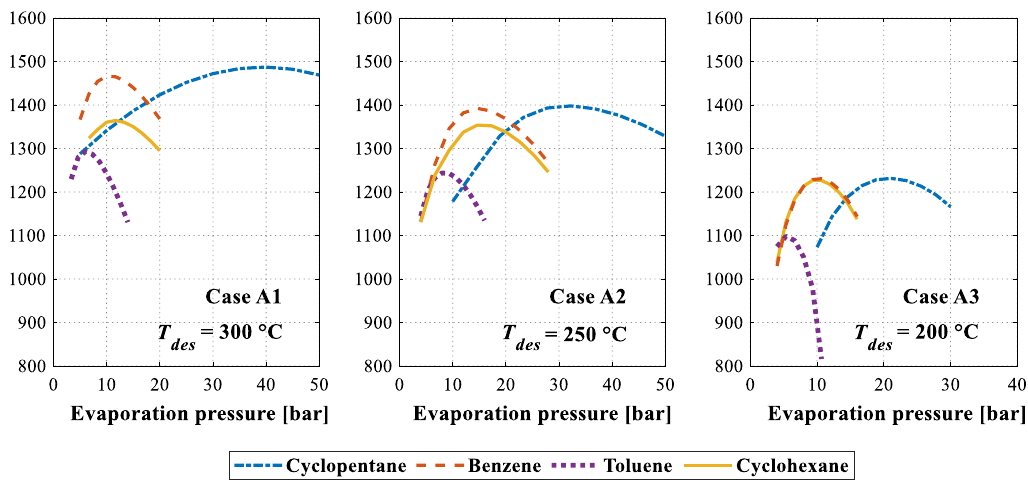
Figure 8. Sensitivity analysis results on organic fluid and IHTF design temperature in Case A layout and different IHFT temperature cases.